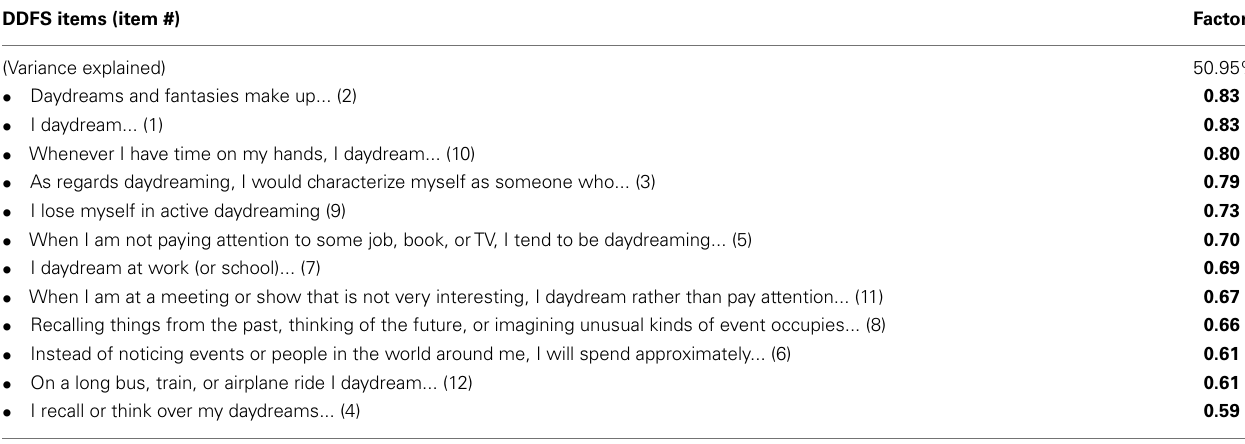
Table 2 | Pattern matrix factor loadings for the principal component analysis of the DDFS items ( N = 100, sampleA).